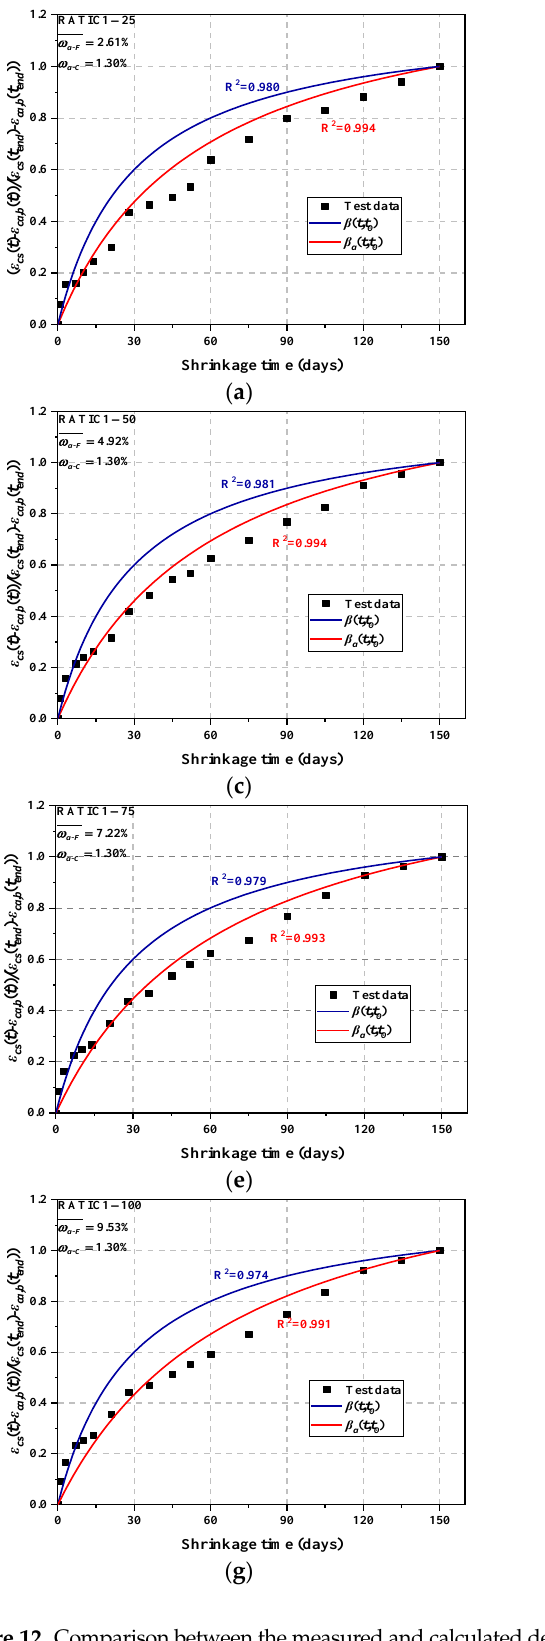
Figure 12. Comparison between the measured and calculated development of normalized total shrinkage with the time of RATIC. ( a ) RATIC1-25; ( b ) RATIC2-25; ( c ) RATIC1-50; ( d ) RATIC2-50; ( e ) RATIC1-75; ( f ) RATIC2-75; ( g ) RATIC1-100; ( h )